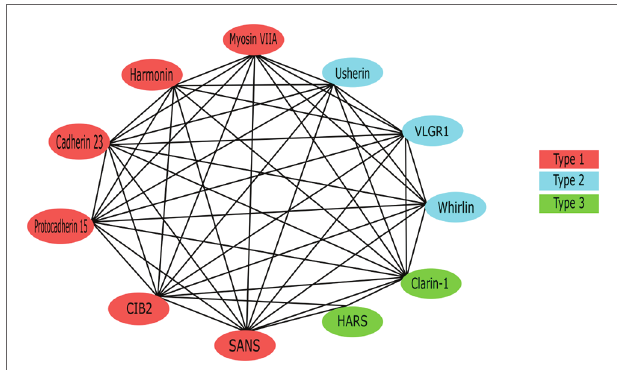
FIGURE 4 | The Usher protein interaction network. All previously reported interactions among Usher proteins have been